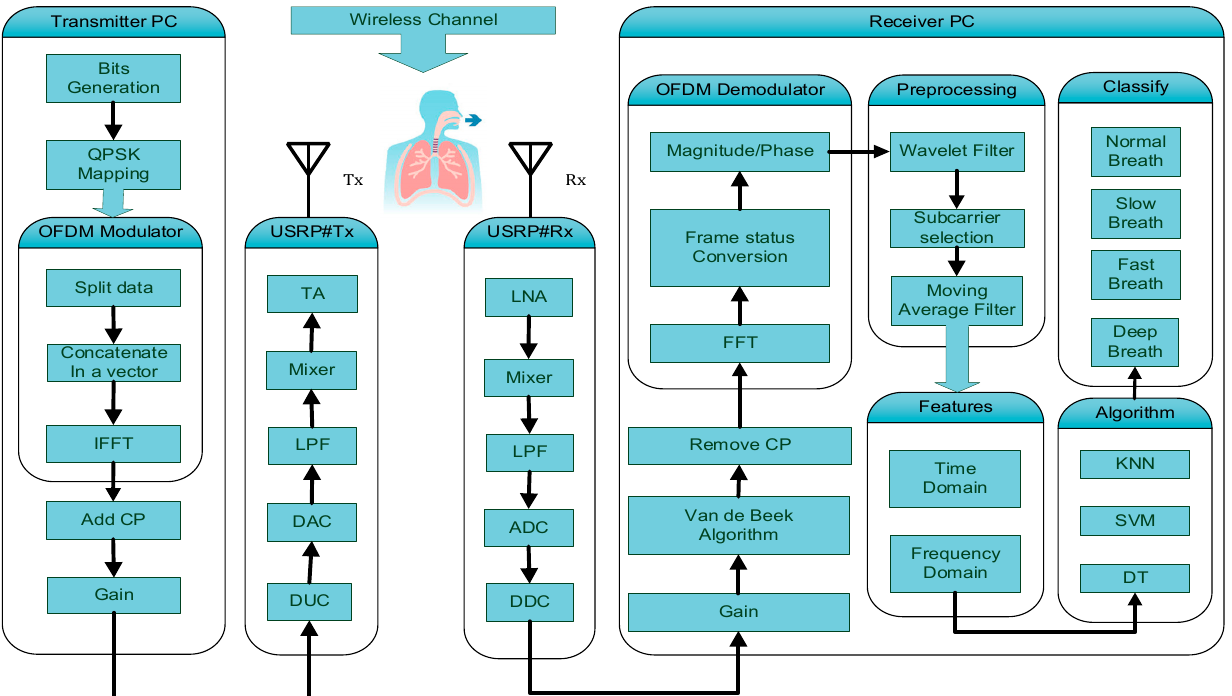
Figure 1. Design of intelligent SDR platform for connected health applications.